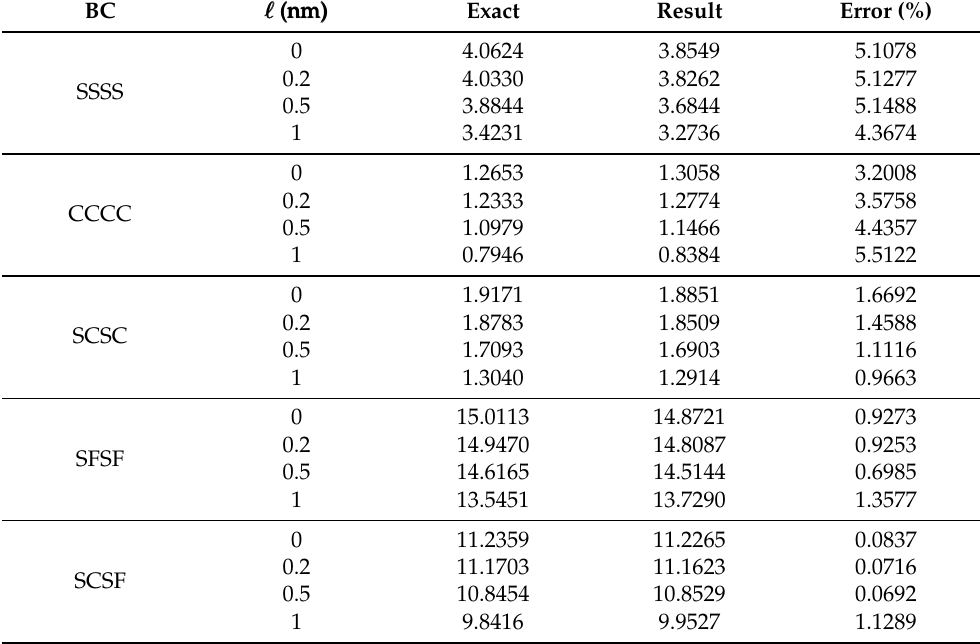
Table 4. Values of ¯ w for 5 × 5 nodal distribution, obtained for α C = 2.38, q = 0.01, α s = 2.4.